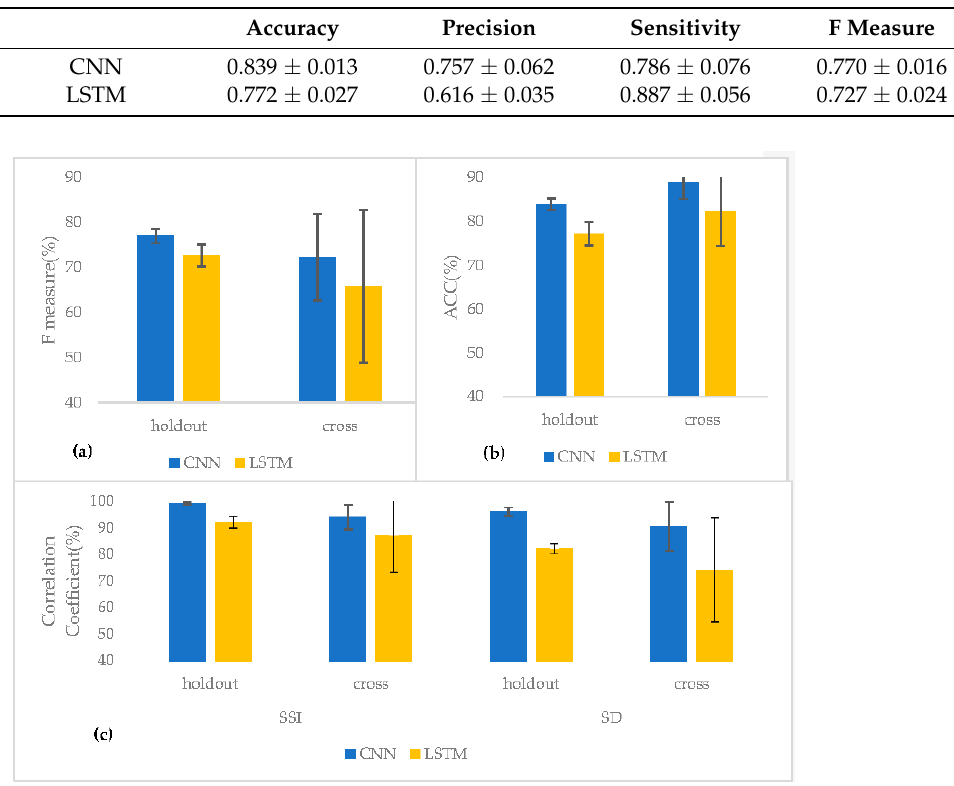
Figure 7. Two BS recognition models; CNN and LSTM are compared by using two evaluation methods; a holdout and a cross evaluation. ( a ) F measure results. ( b ) ACC results. ( c ) The correlation coefficient (%) for sound-to-sound interval (SSI) and sound duration